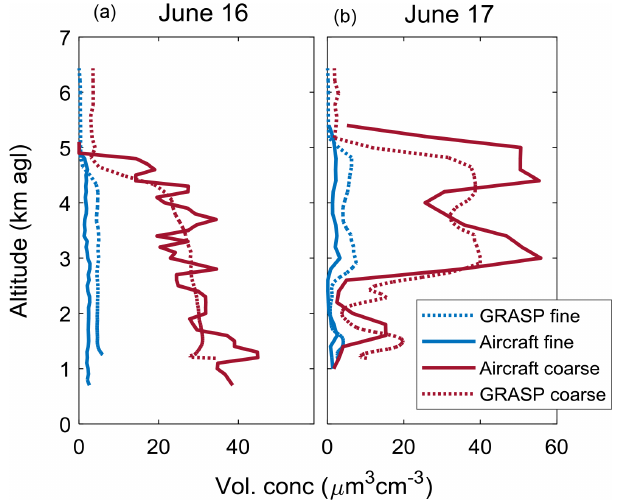
Figure 5. Profiles of aerosol volume concentration for the fine (blue) and coarse (red) mode obtained from GRASP/DS1 (dot- ted line), and aircraft in situ/DS3 measurements (solid line) on 16 June (a) and 17 June (b)